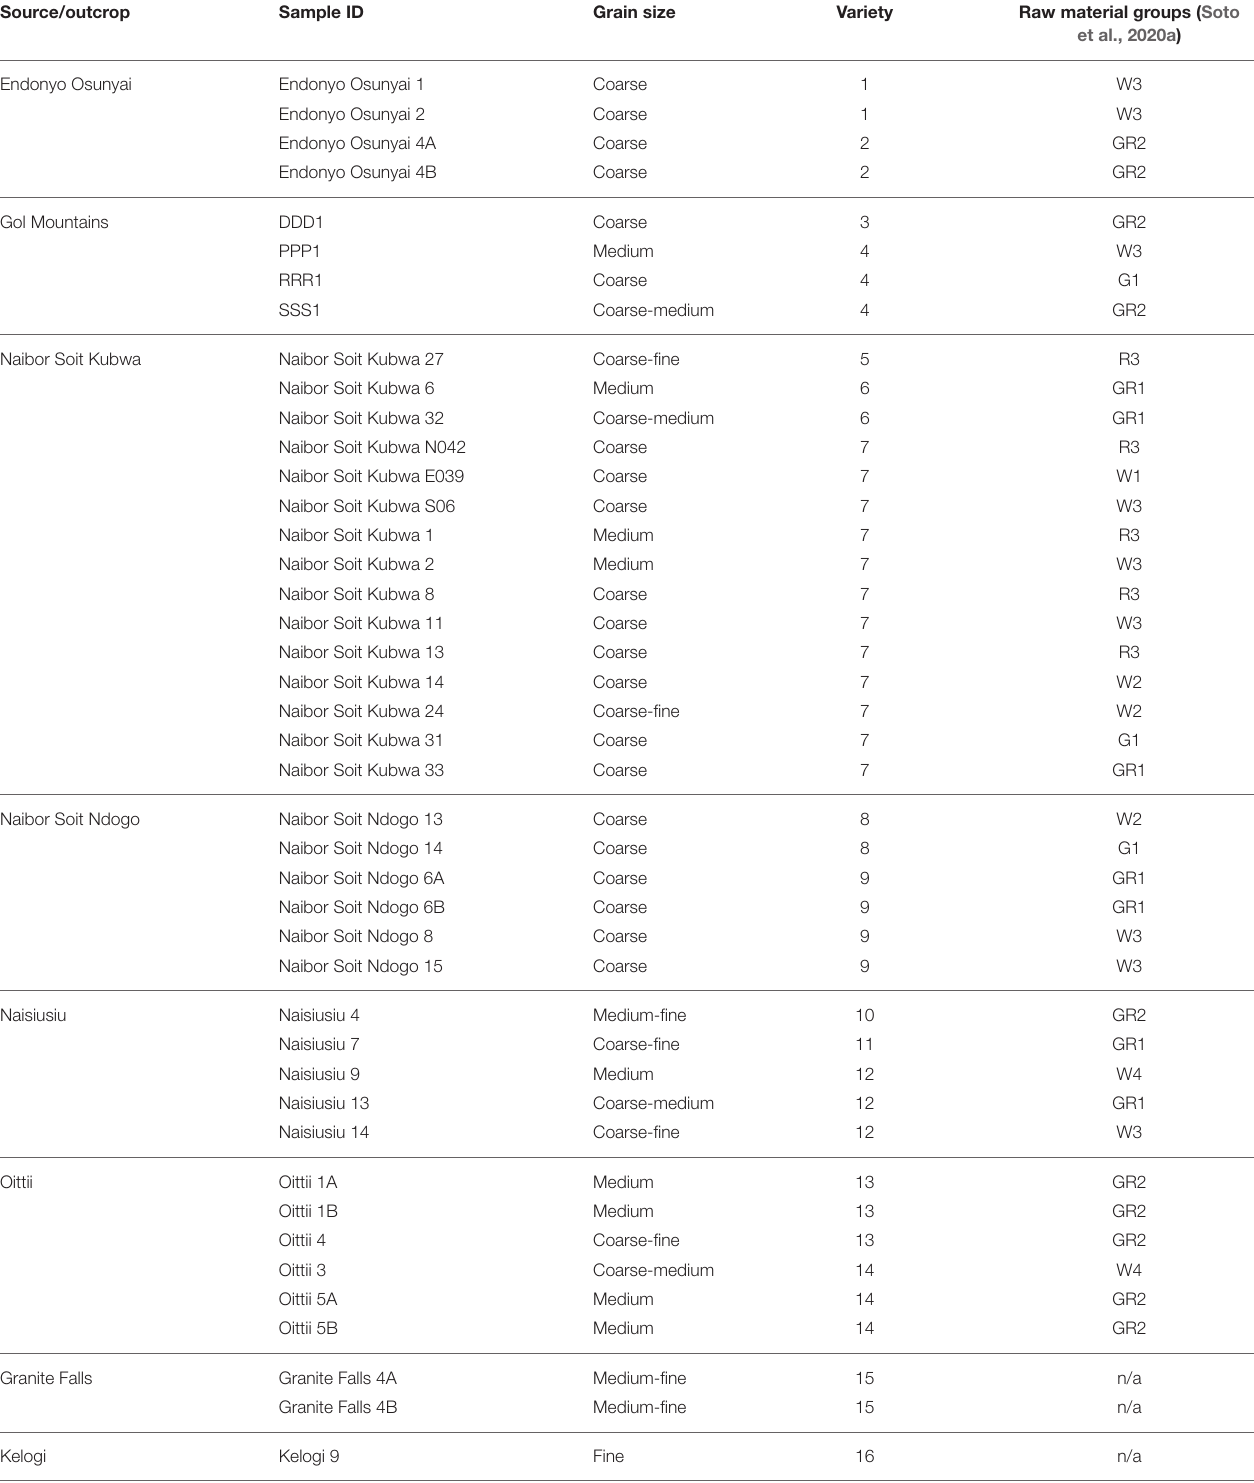
Refer to Table 2 for sample